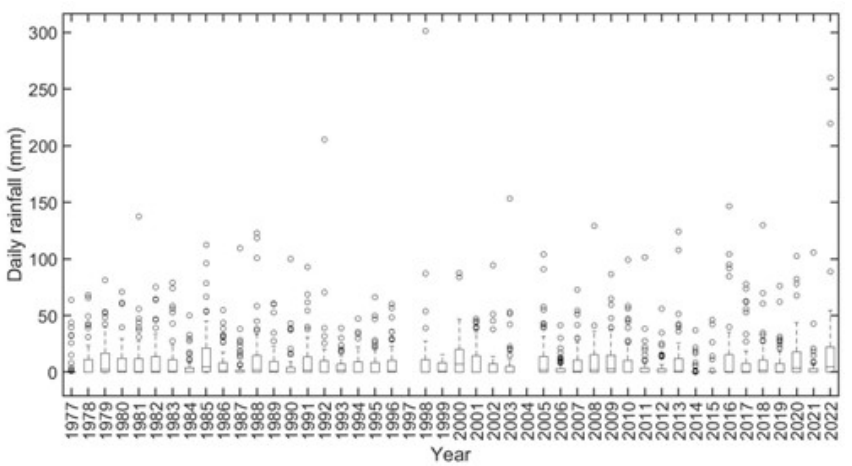
Figure 3. The long-term precipitation time series was created from two weather stations from INMET (A603 – Duque de Caxias and A610 – Pico do Couto), two weather stations from INEA (2243238 – Xeren and 2243235 – Andorinhas), and one from Cemaden (São Sebastião).